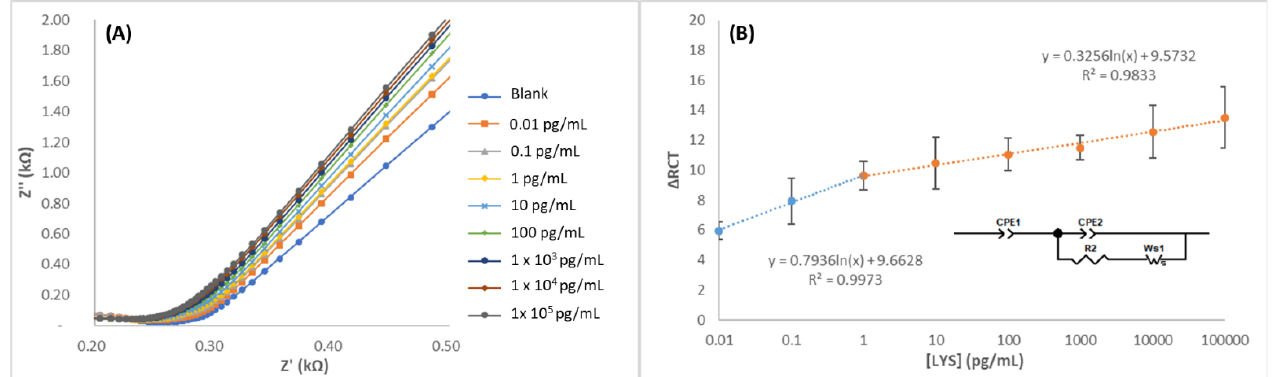
Figure 6. ( A ) Nyquist spectra of MIPPy/GO@Fe 3 O after incubation with LYS in 1 1 × 10 5 pg/mL range and ( B ) the equivalent circuit and calibration curve that was obtained from the fitting process.